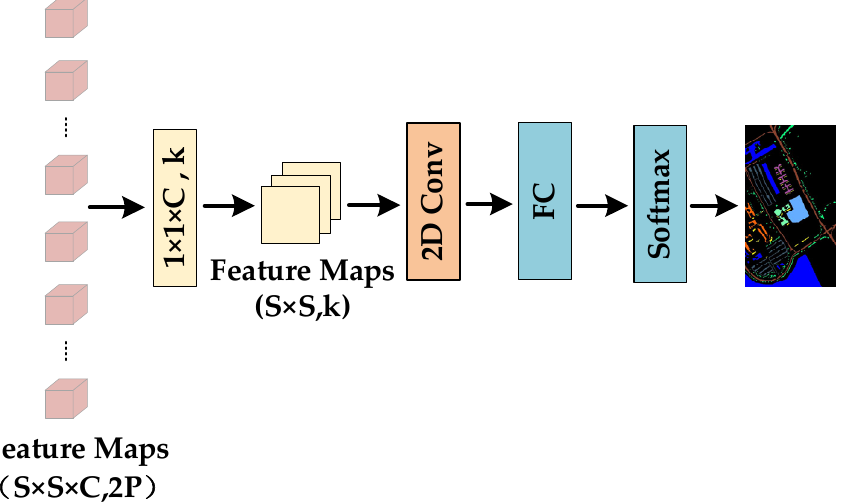
Figure 13. 2DCNN for classification.